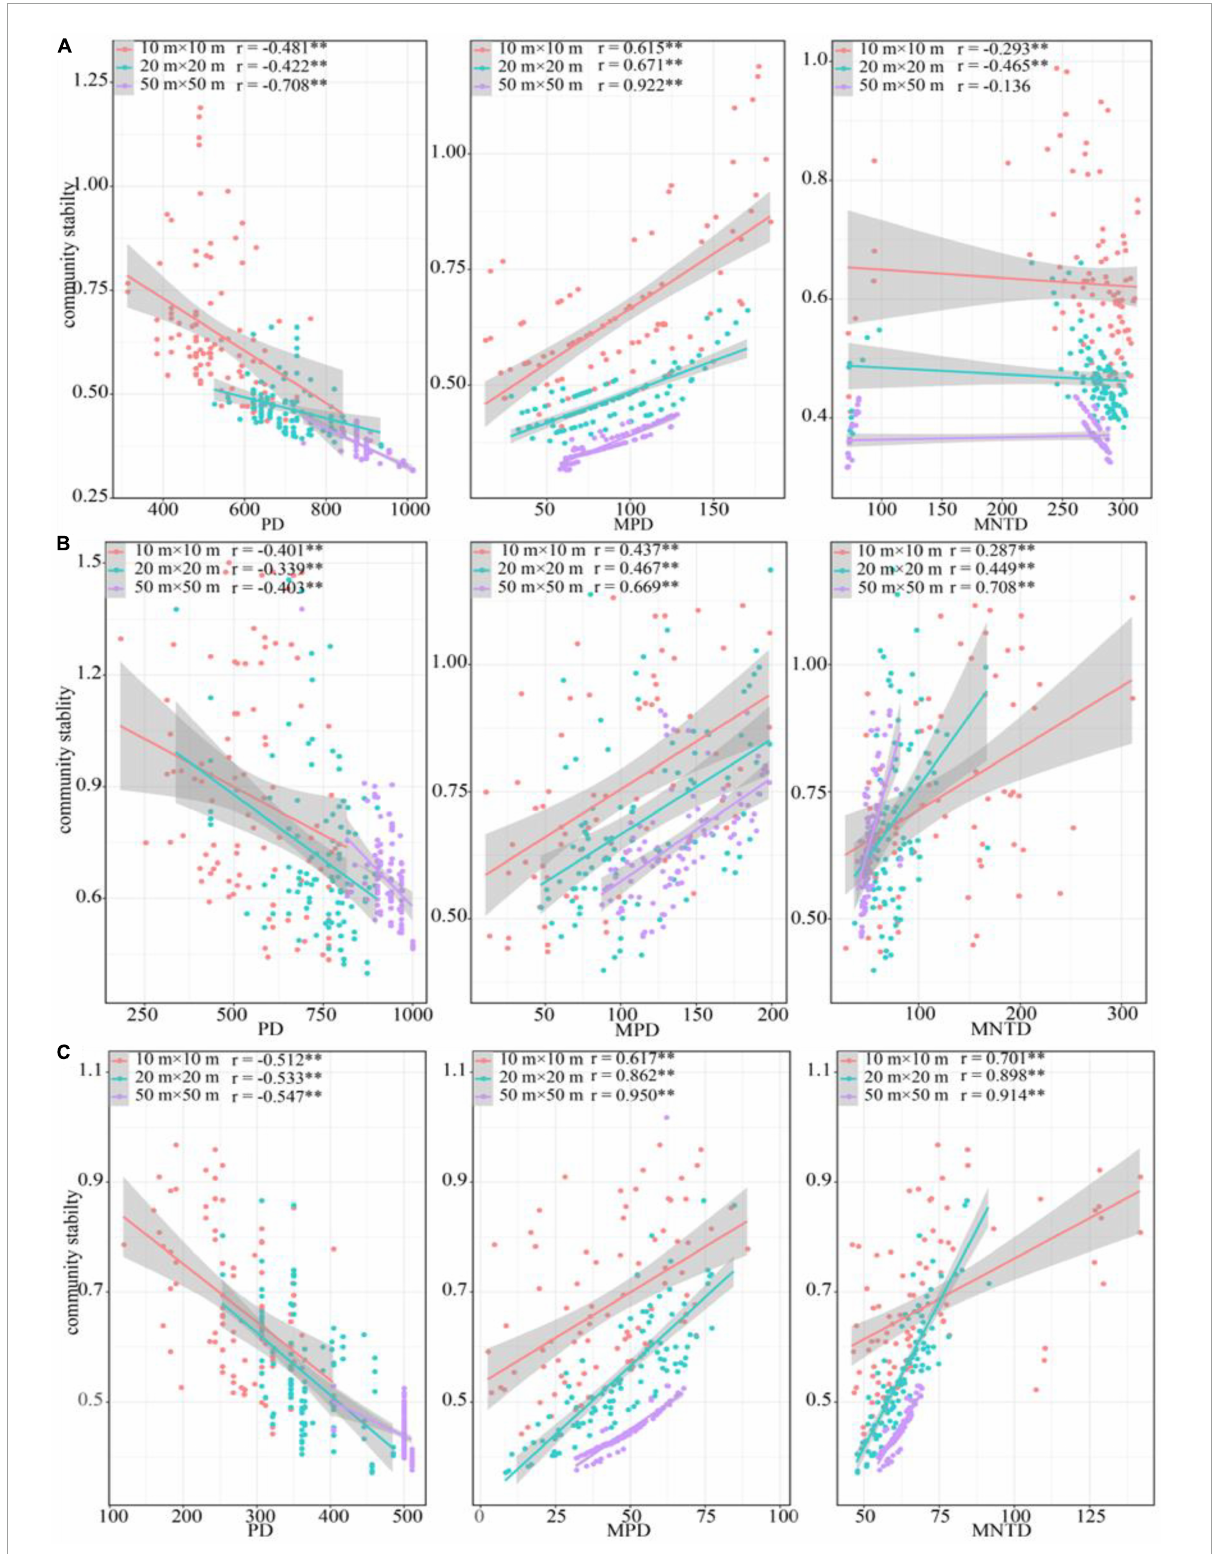
FIGURE6 Relationship between phylogenetic diversity and community stability. (A) Riparian forest. (B) Ecotone community. (C) Desert shrubs. ** P < 0.01.